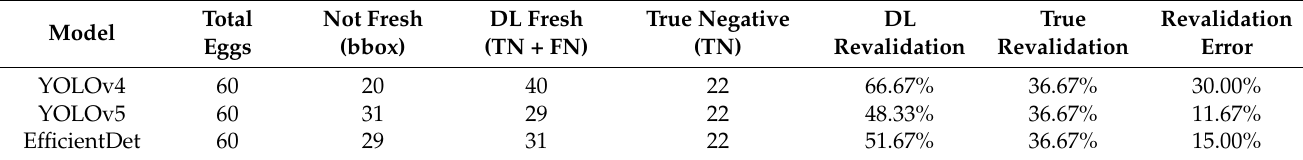
Table 8. Revalidation amount according to DL object detection